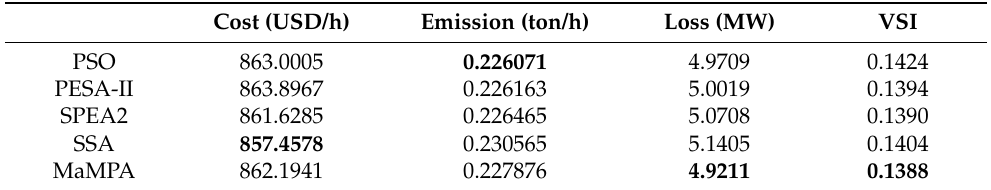
Table 13. Best compromised solutions for solving many-objective OPF (MaOPF) problems by using all considered objectives as the objective functions in the IEEE 30-bus system (case 19).